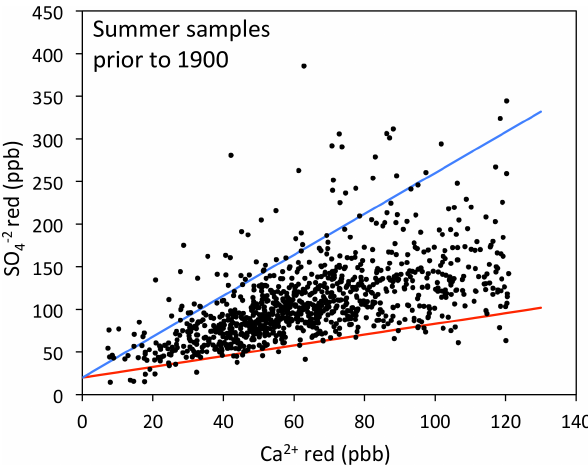
Figure 10. Sulfate versus calcium concentrations in summer sam- ples free of large dust events (red. values) in ice deposited prior to 1900. The blue line refers to a pure gypsum composition. The red line illustrates a lower envelope of the sulfate-to-calcium rela-